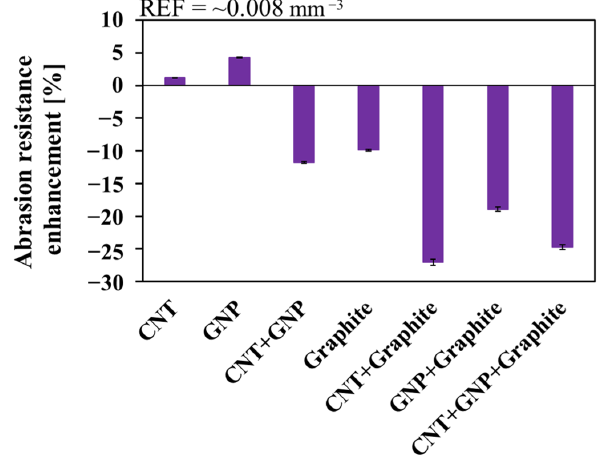
Figure 5. Abrasion resistance enhancement of the different systems. The measured values and their errors are detailed in Table S1.